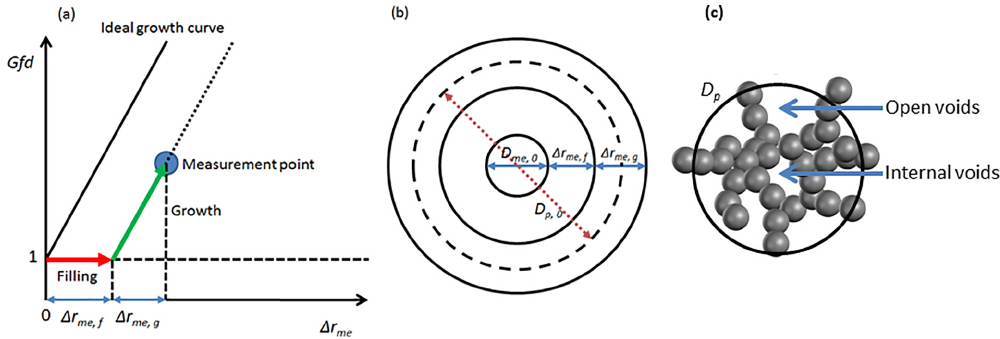
Figure 2. Illustration of the framework for quantifying the morphological transformation and structure of soot aggregate.